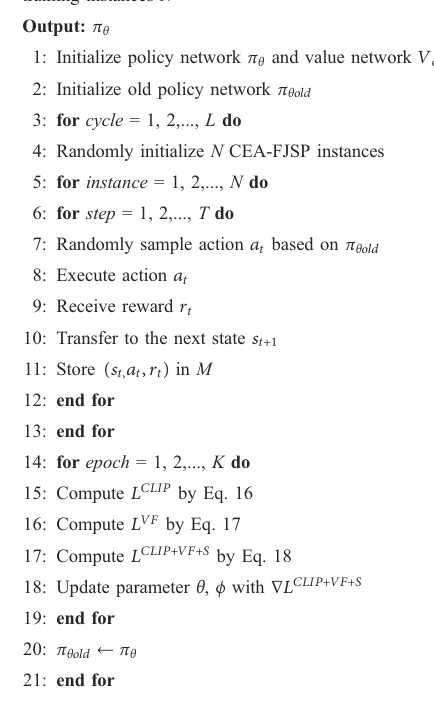
Algorithm 1. Training process for CEA-FJSP using PPO